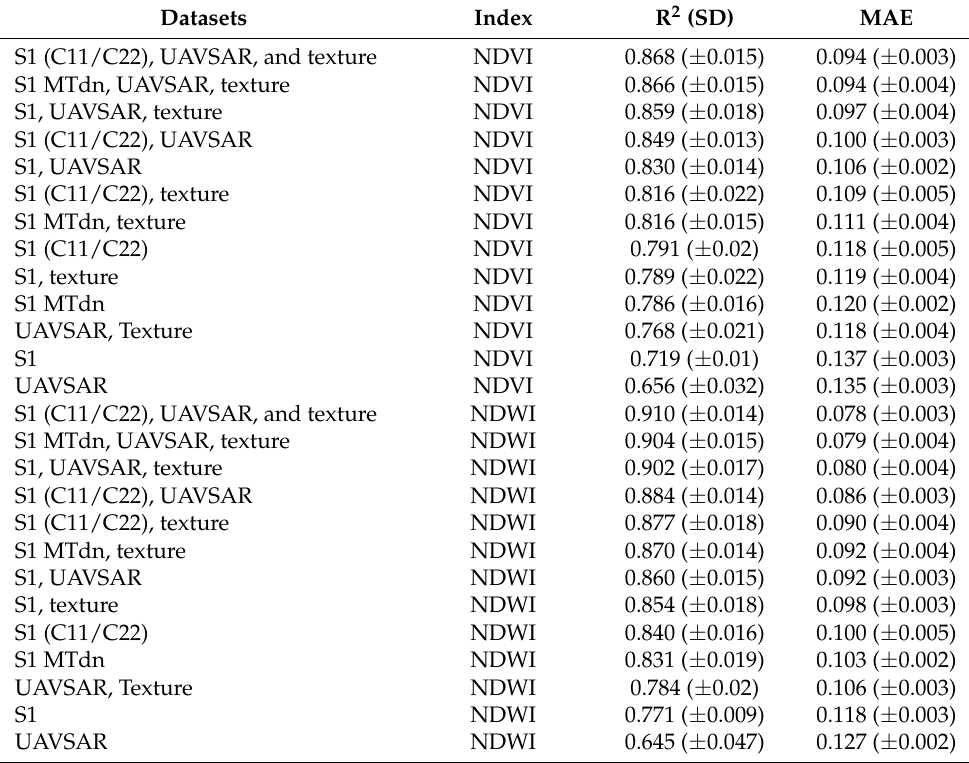
Table 2. Comparison of RF model performance for the different dataset combinations for both spectral